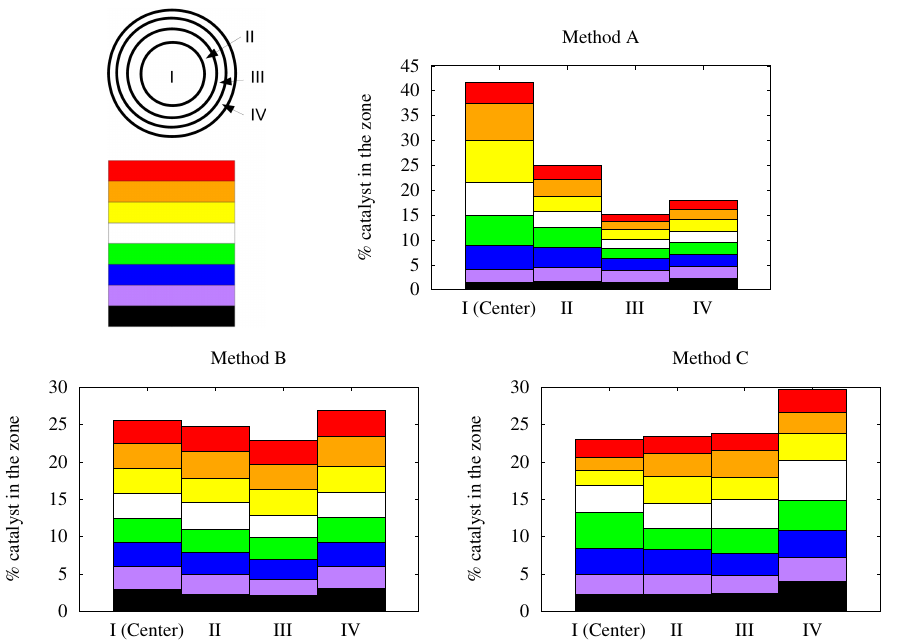
Figure 11. Zones of thickness measurement and distribution of the Bi foam cylinder for the three